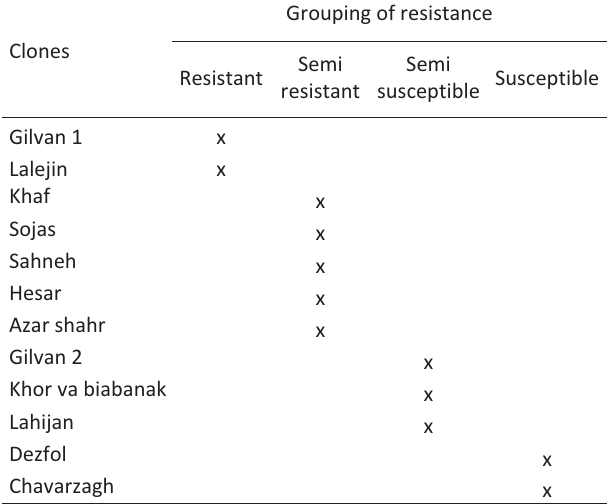
Table 10 ­ Reaction of 12 Iranian garlic clones to rust fungus in a two years field traits under natural